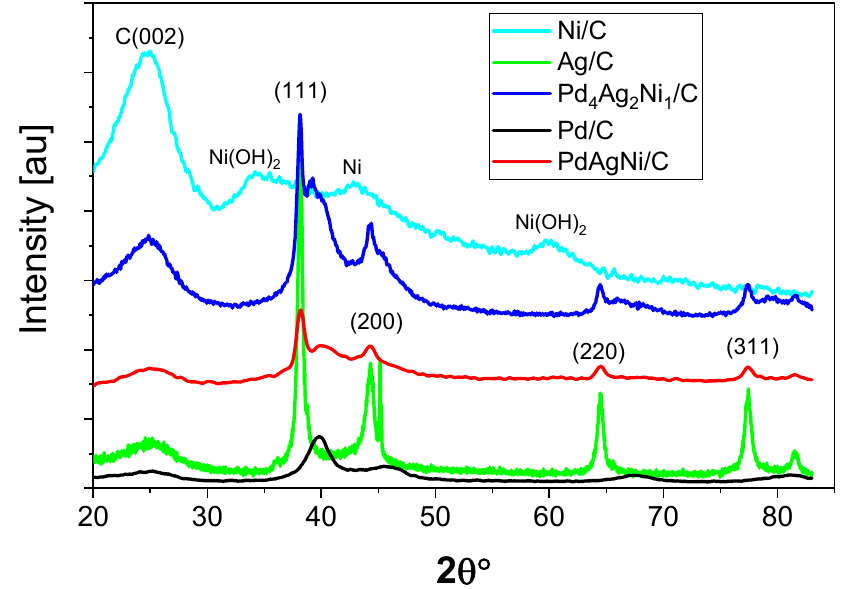
Figure 1. X-ray diffraction patterns of Pd/C, Ag/C, Ni/C, PdAgNi/C, and Pd 4 Ag 2 Ni 1 Figure 1. X ‐ ray diffraction patterns of Pd/C, Ag/C, Ni/C, PdAgNi/C, and Pd 4 Ag 2 Ni 1 /C.